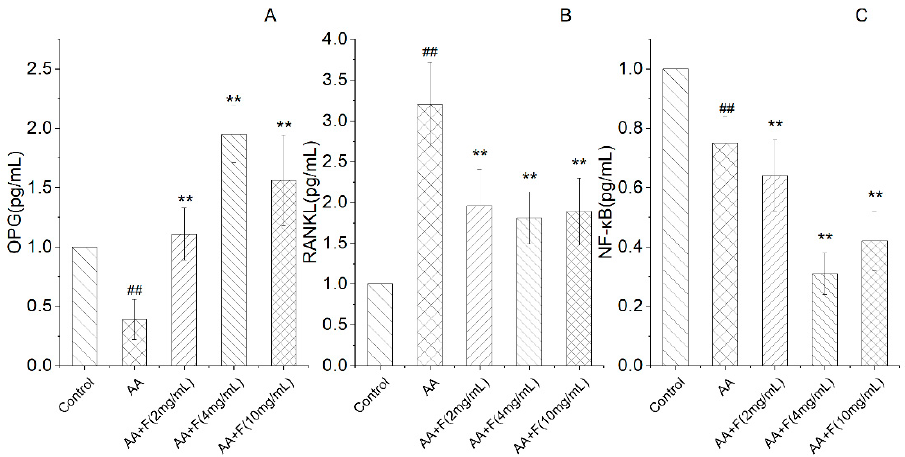
Figure 2. Effects of different treatments on levels of serum cytokines TNF- α ( A ), IL-1 β ( B ), PGE2 ( C ), and on levels of signaling pathway proteins RANKL ( D ), OPG ( E ) and RANKL/OPG ( F ) in arthritic rats (x ± SD). Error bars represent standard deviations ( n = 6). As compared with the control group, # p < 0.05 and ## p < 0.01 indicate that serum cytokine levels of the untreated arthritis model (AA) group were significantly different from corresponding control group levels. As compared with the untreated arthritis model (AA) group: * p < 0.05 and ** p < 0.01 indicated significant reduction in serum cytokine levels in the treated arthritis model group.